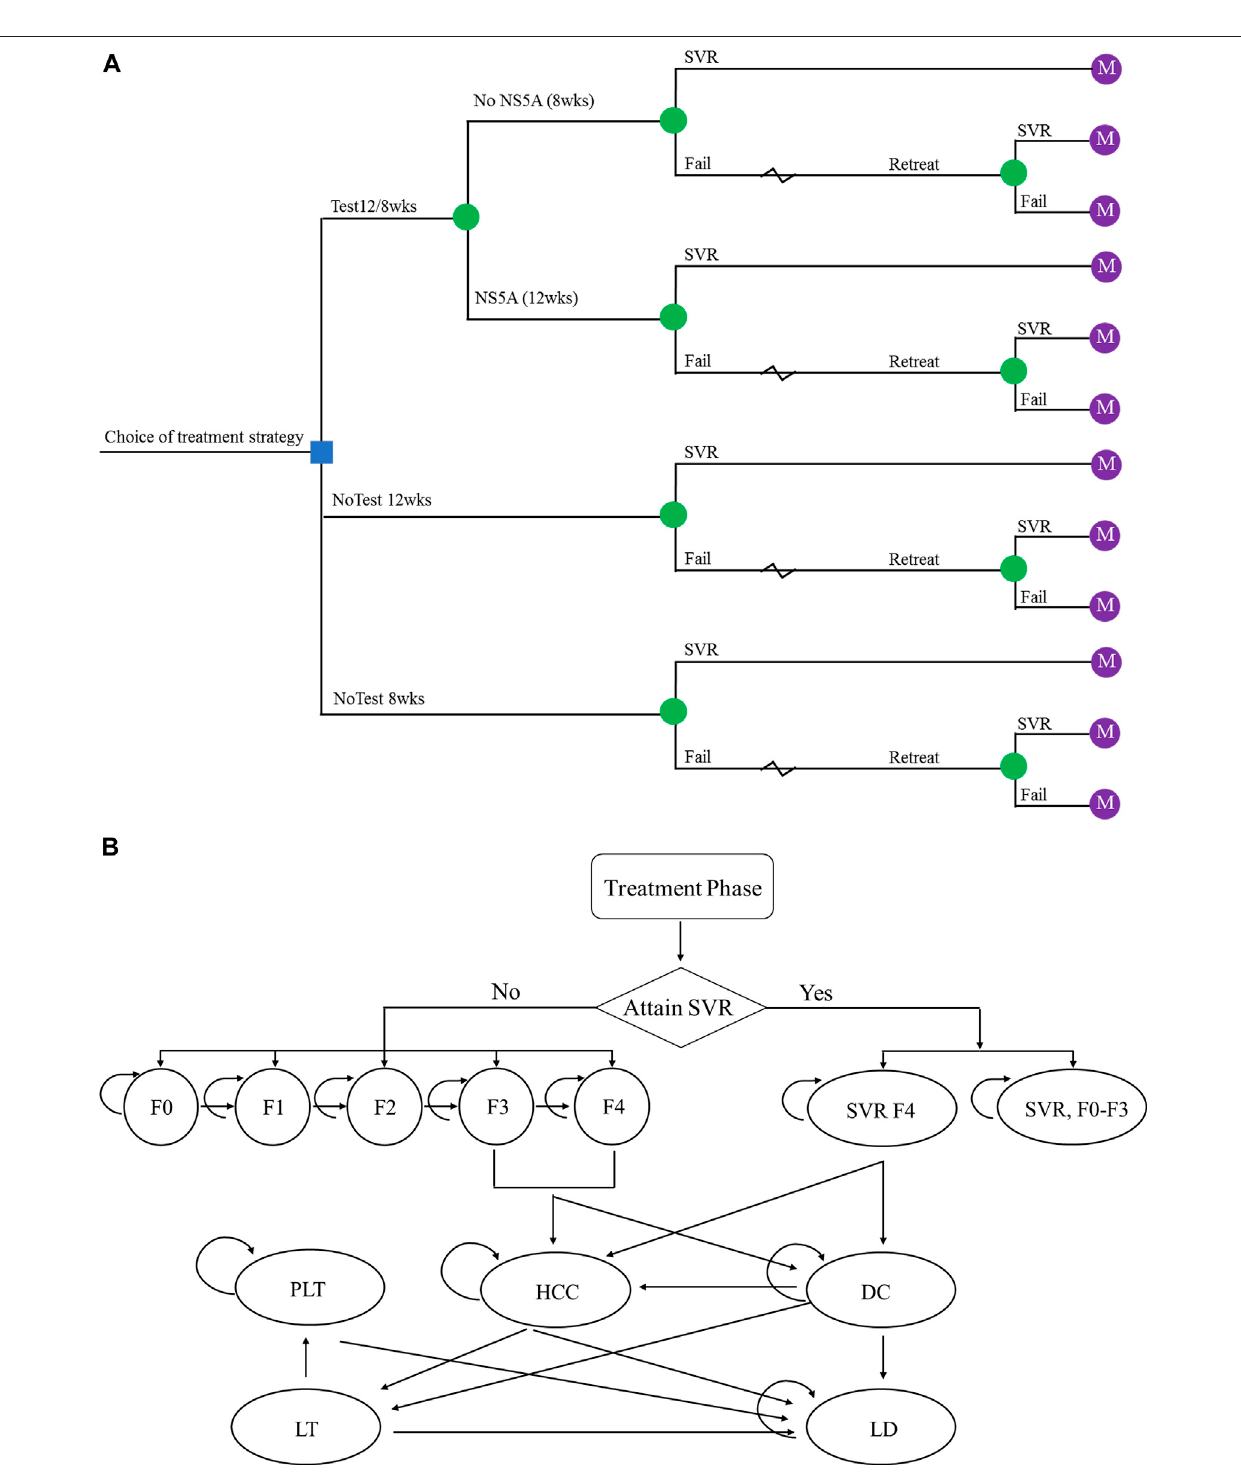
FIGURE 1 | The schematics of (A) the decision tree and (B) the Markov state transition model. Abbreviations: SVR, sustained virologic response; F0 – F4, Metavir fi brosis score; SVR F0-F3, patients diagnosed at F0 – F3 fi brosis stage achieved SVR; SVR F4, patients diagnosed at F4 fi brosis stage achieved SVR; DC, decompensated cirrhosis; HCC, hepatocellular carcinoma; LT, liver transplant; PLT, post-liver transplant; LD, liver-related death.